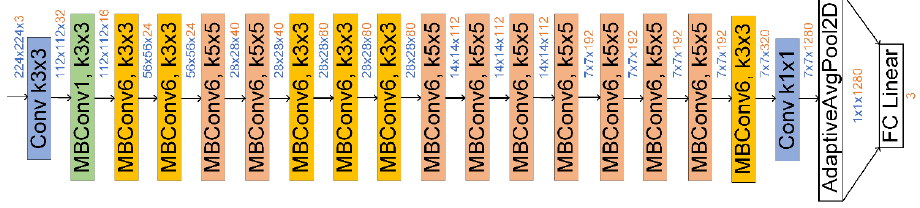
Figure 12. The EfficientNet-B0 architecture diagram used for volcano image classification.